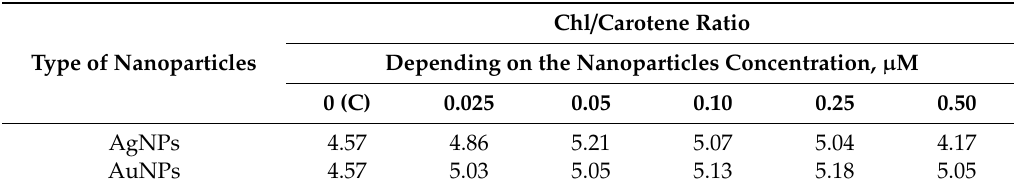
Table 1. E ff ect of nanoparticles on the chlorophyll / carotene ratio. Chl / Carotene Ratio Depending on the Nanoparticles Concentration, µ M Type of Nanoparticles 0